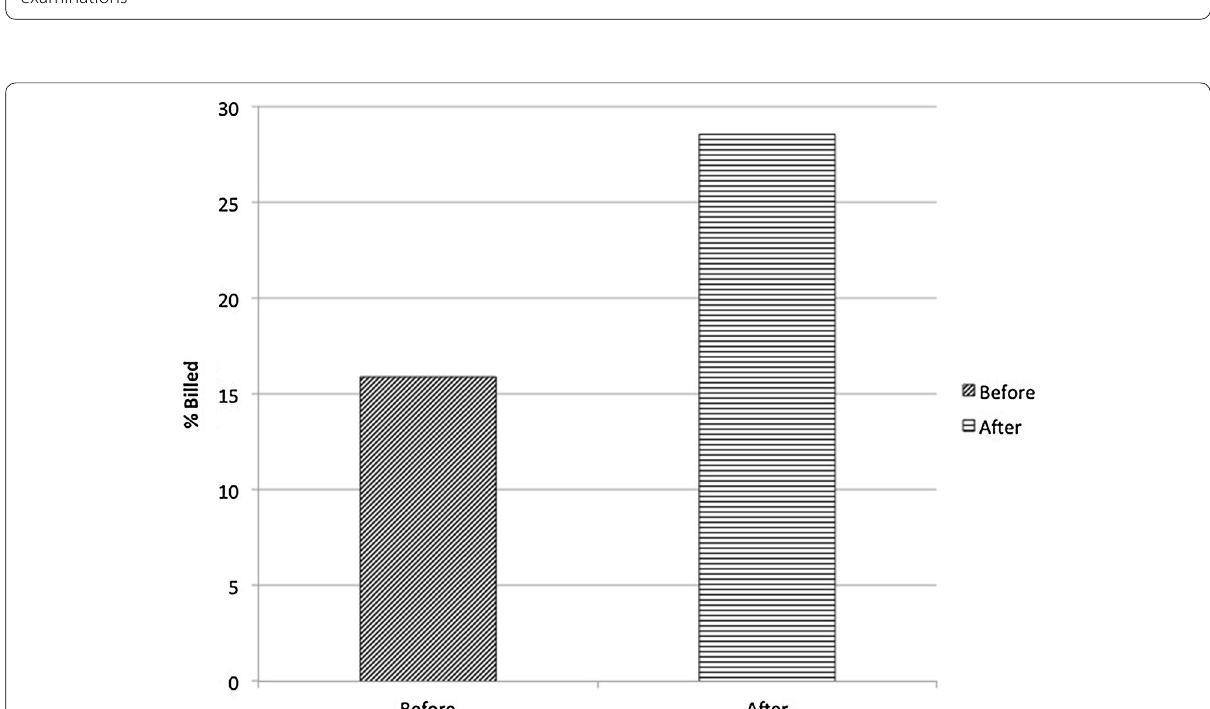
Fig. 3 The change in the percentage of scans billed after being reported to the medical coders by the department pre- and post-task force inter- vention. X-axis illustrates pre- and post-intervention periods ( dark slanted hashed bar pre-intervention data; horizontal hashed bar post-intervention data). Y-axis represents the percentage of examinations